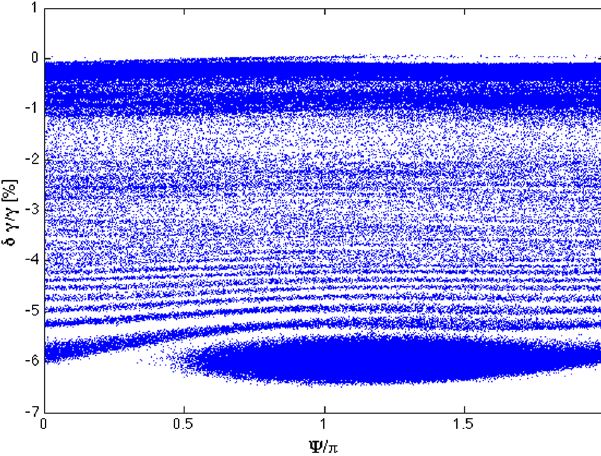
FIG. 5. Longitudinal phase space for the core 6 fs of the beam at the undulator exit in the 3.1 MeV energy spread, 5 MW seed case. Particle detrapping in the second half of the undulator is caused by the synchrotron sideband instability. Note that multiple phase spaces are overlapped within one wavelength in the 0 < Ψ < 2 π